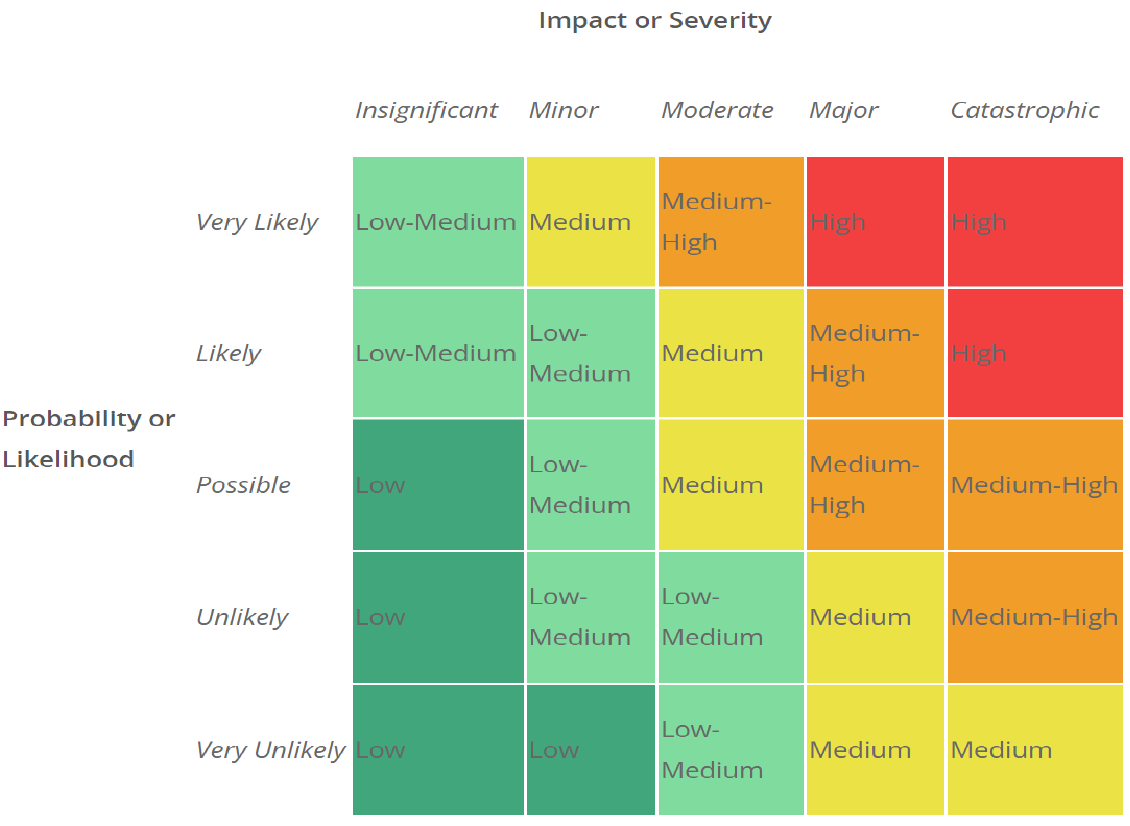
Figure 3. Risk Exposure Assessment Matrix. Source: http://apppm.man.dtu.dk/index.php/Impact_ and_Probability_in_Risk_Assessment (accessed on 1 October 2022).